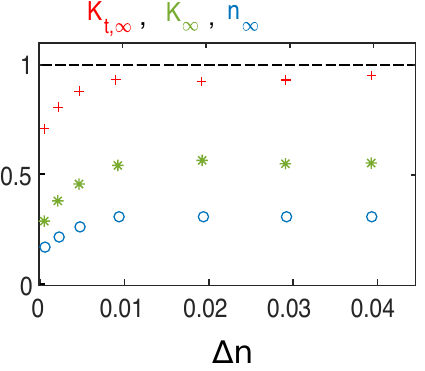
Figure 13. Variation with ∆ n , at asymptotic time, of the density n ∞ (blue circles) and the kinetic energy K ∞ (green stars) of the accelerated electrons, as well as of the kinetic beam energy K t , ∞ (red crosses). The density and the energy are normalized by the initial beam density and kinetic energy,